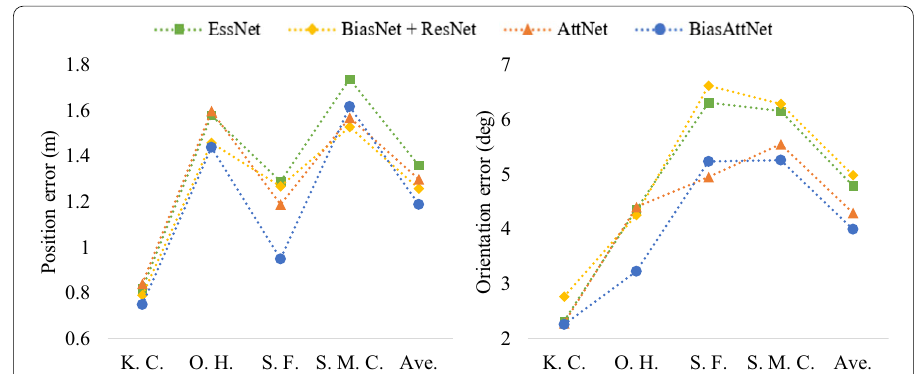
Fig. 10 Position and orientation errors of the baseline and the proposed pipeline. We demonstrate the proposed modules are effective by progressively integrating the modules. (K.C. stands for King’s College, O.H. for Old Hospital, S.F. for Shop Facade, S.M.C. for St Mary’s Church, and Ave. for Average.)